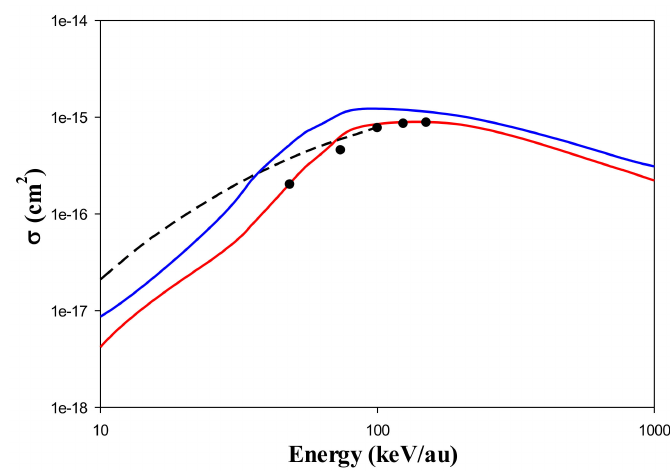
Figure 3. Cross section for ionization of H(1s) by Be 4 + as a function of projectile energy. CTMC (red solid line), QTMC-KW (blue solid line), Reference [5] (dash line), Reference [9] ( • ).